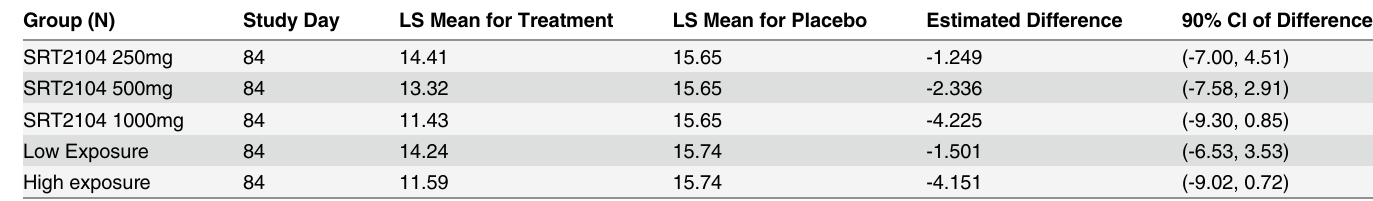
Table 3. Adjusted Mean PASI Day